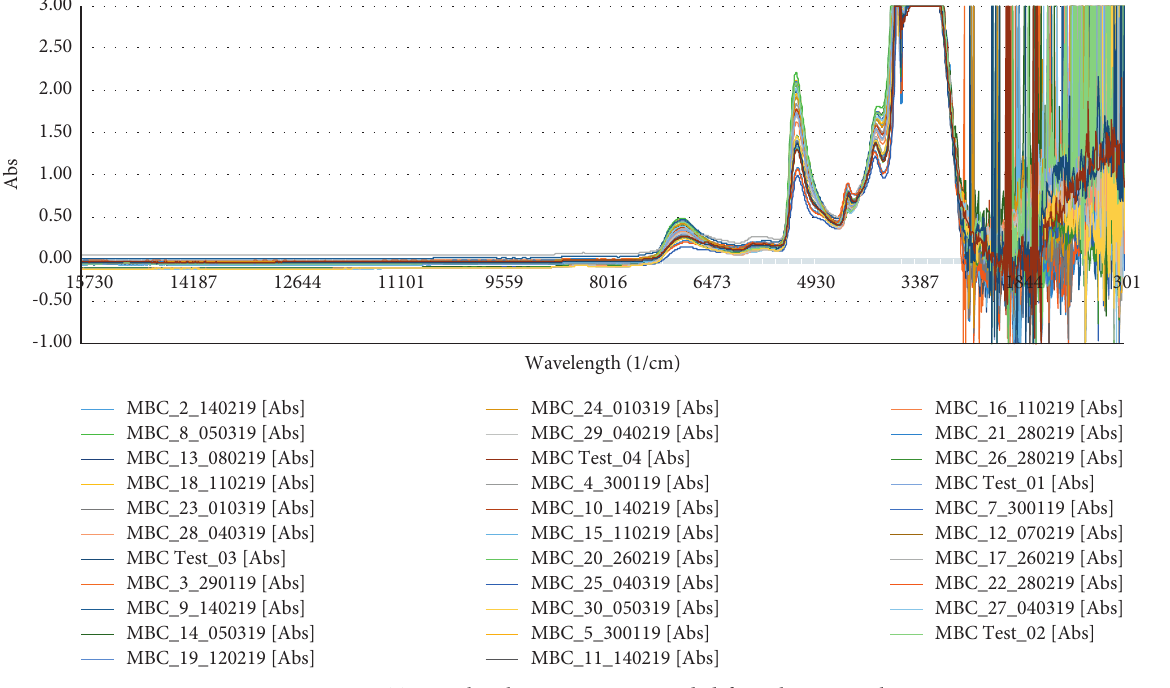
Figure 2: Raw FT-NIR absorbance spectra recorded for solvent samples.